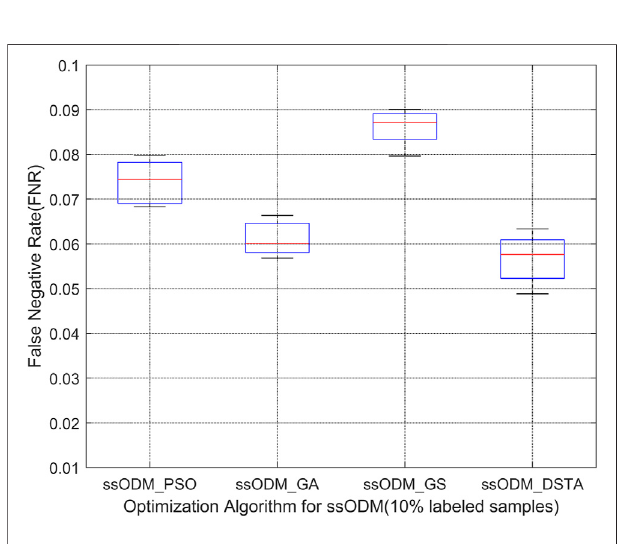
FIGURE 10 | Boxplot of FNR of CAN communication fault detection regarding blade 1 servo driver (10% labeled